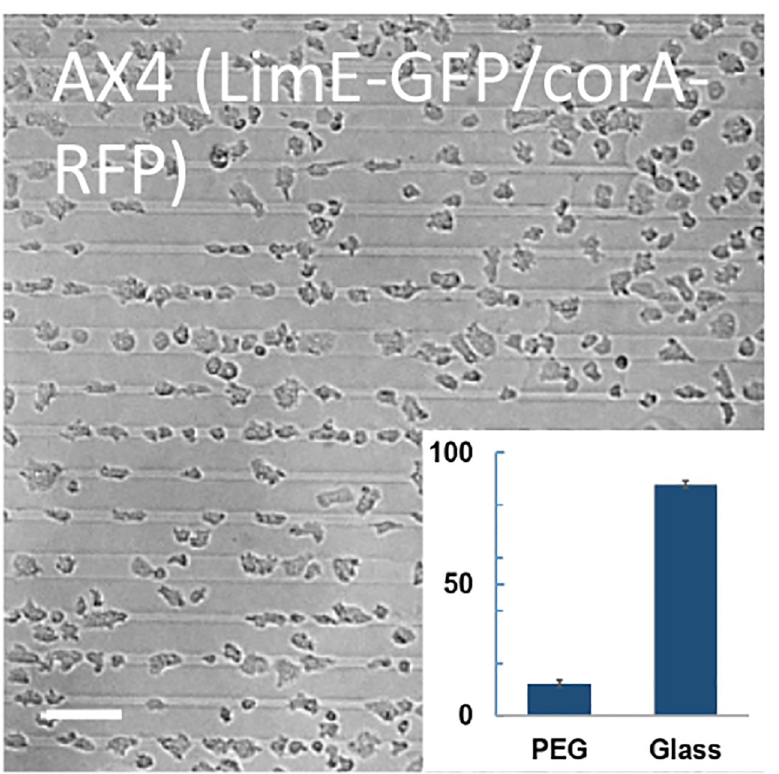
Fig 6. Vegetative AX4 cells with fluorescent markers on micropatterned substrates. Micrograph of vegetative AX4 cells expressing LimE-GFP/corA-RFP taken 10 min after plating. Inset: relative coverage of cells on PEG-gel and glass stripes. (Scale bar: 50 μm ).